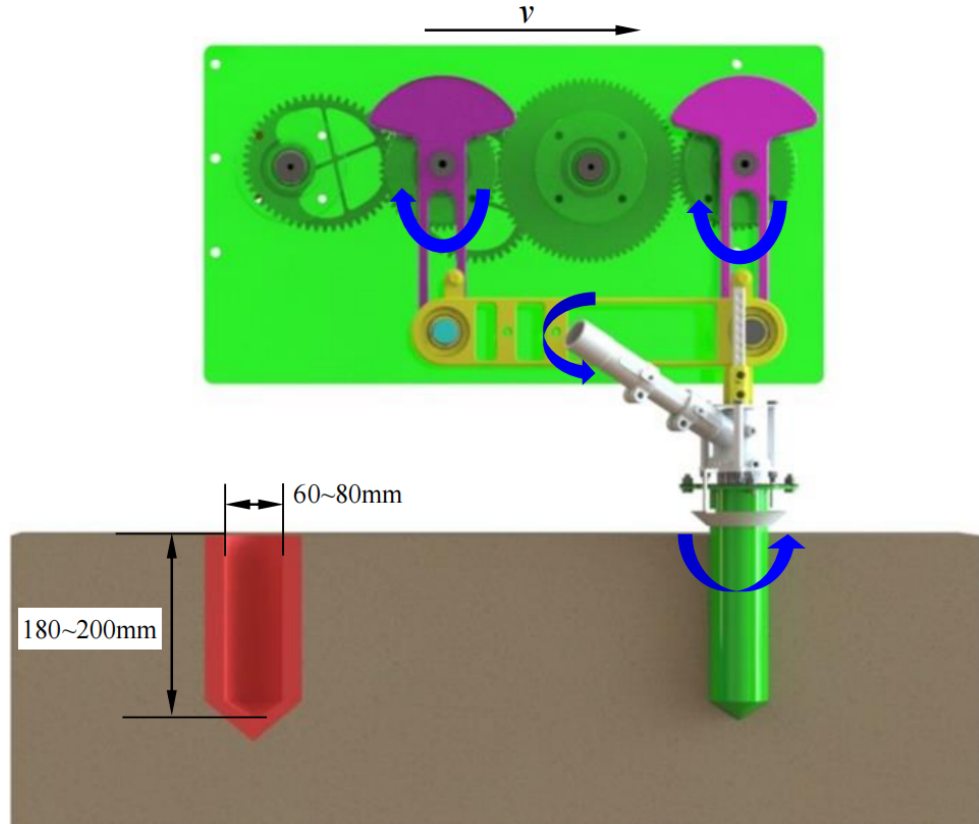
Figure 2. Working principle of the cavitating mechanism. Notes: v represents the operating velocity of the mechanism. Table 1. Kinematic pair configuration table of multi-body dynamics